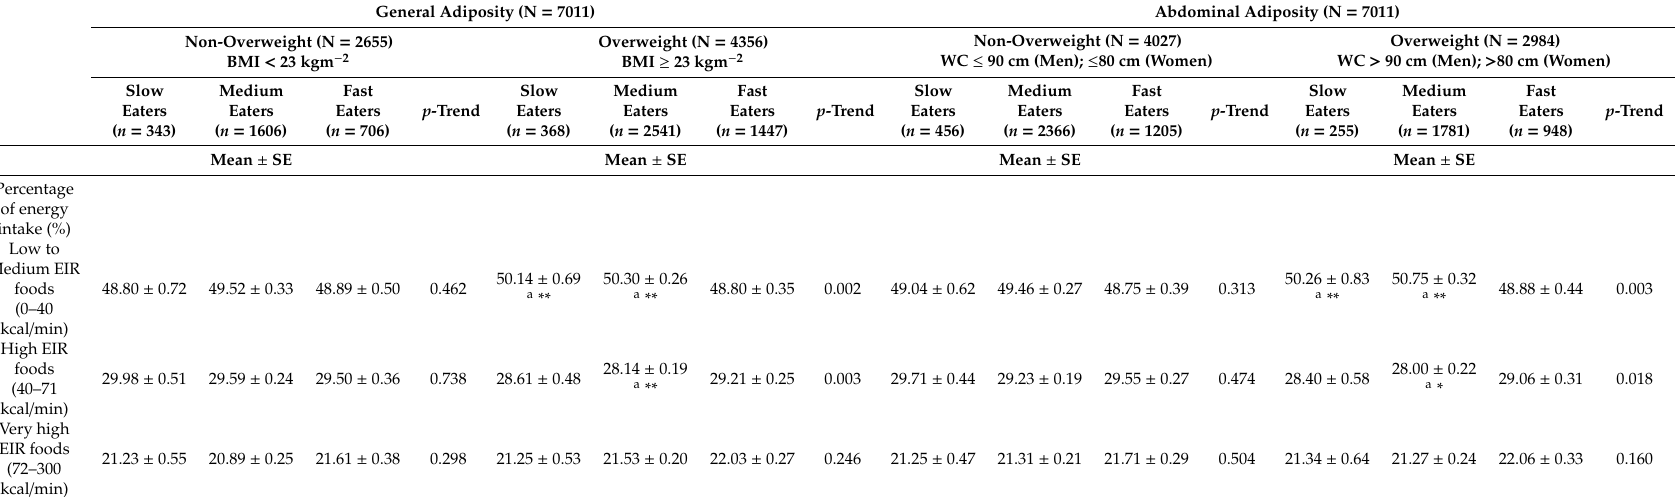
Table 2. Multivariable models of di ff erences in relative consumption of higher and lower energy intake rate (EIR) foods among individuals being overweight or abdominally overweight across their self-reported eating rate (SRER) groups in the Singapore Multi-Ethnic Cohort 2 1